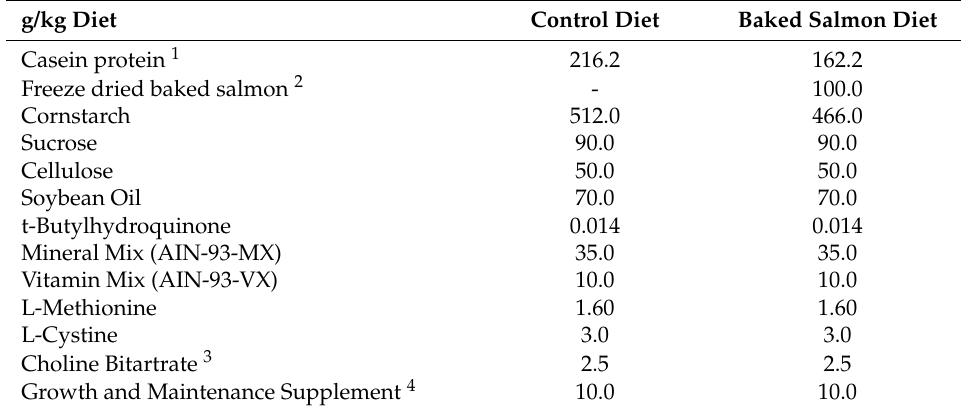
Table 1. Composition of the experimental